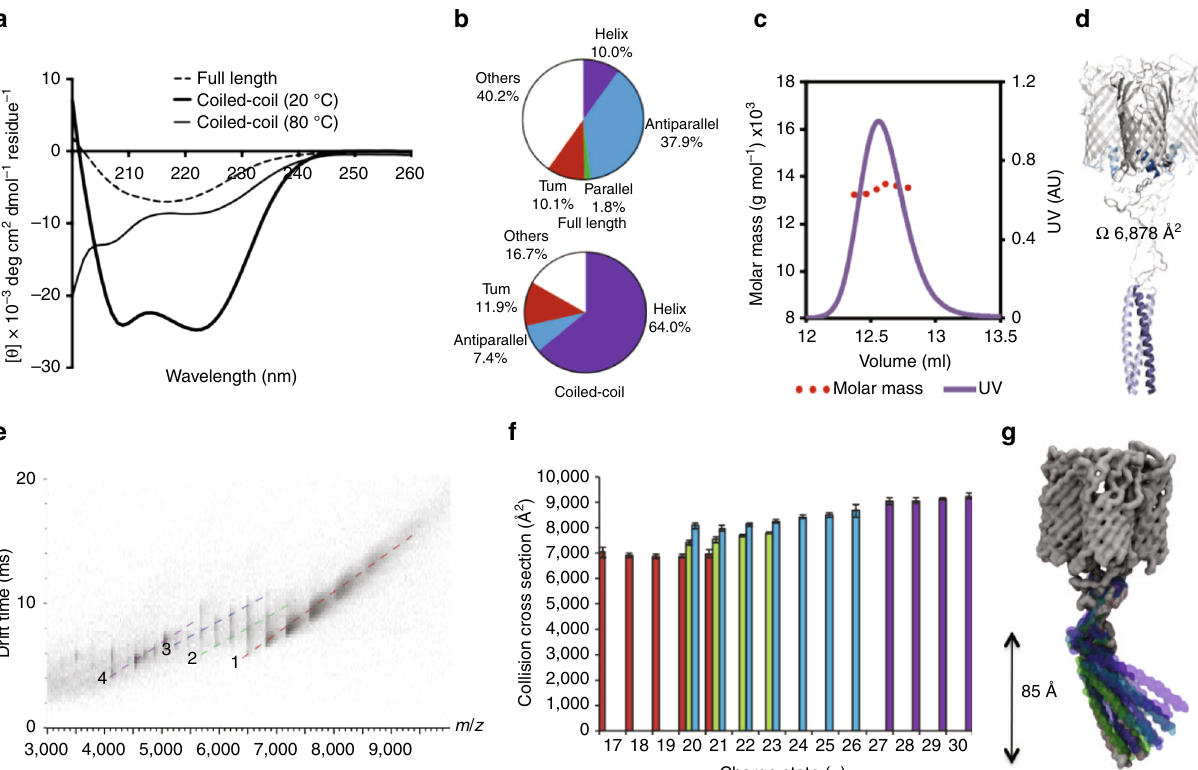
Fig. 3 Biophysical characterisation of the FapF N-terminal coiled coil. a Far-UVCD spectra for the full-length FapF ( dashed line ) and the coiled-coil peptide (D3 – Q40) at 20 °C ( thick solid line ) and 80 °C ( thin solid line ). b Secondary structure composition for full-length FapF and the coiled-coil peptide (20 °C) as estimated by the BeStSel method. c SEC-MALS pro fi le of the coiled-coil indicating a monodisperse sample corresponding to the trimer. d Atomistic model of full-length FapF coloured corresponding to the structural boundaries shown in Fig. 1a. The theoretical CCS of this model is shown. e Ion-mobility measurements for puri fi ed full-length FapF. These indicate a population of four main substate populations. f Collision cross-sections of the four different FapF trimer populations. Error bars are derived from an average of three different wave heights. g Motion of the N-terminal domain of full-length FapF observed during coarse-grained simulations. The trajectory was aligned to the barrel and the position of the N-terminal domain at 10 ns intervals are shown ( grey = 0 ns, green = 10 ns, blue = 20 ns, purple = 30